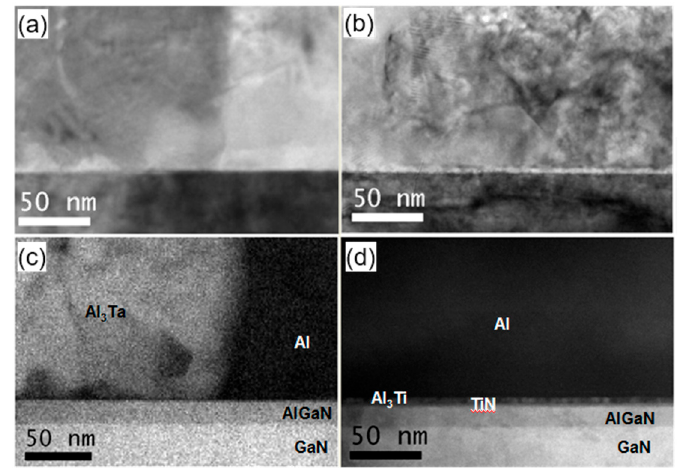
Figure 9. Cross-section Transmission Electron Microscopy (TEM) images of Ta / Al / Ta ( a ) and Ti / Al / Ti ( b ) contacts, and Scanning Transmission Electron Microscopy (STEM) images of Ta / Al / Ta ( c ) and Ti / Al / Ti ( d ) annealed at 600 °C.